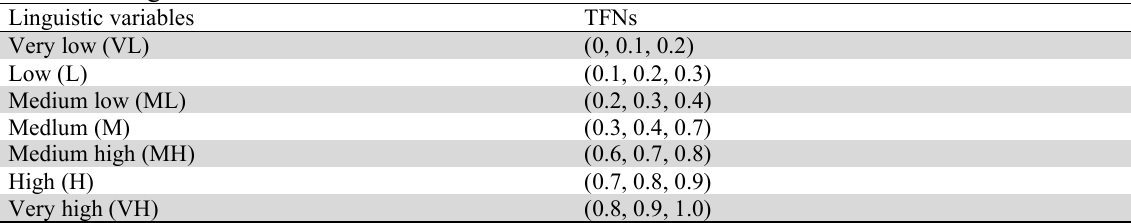
The seven linguistic variables Linguistic